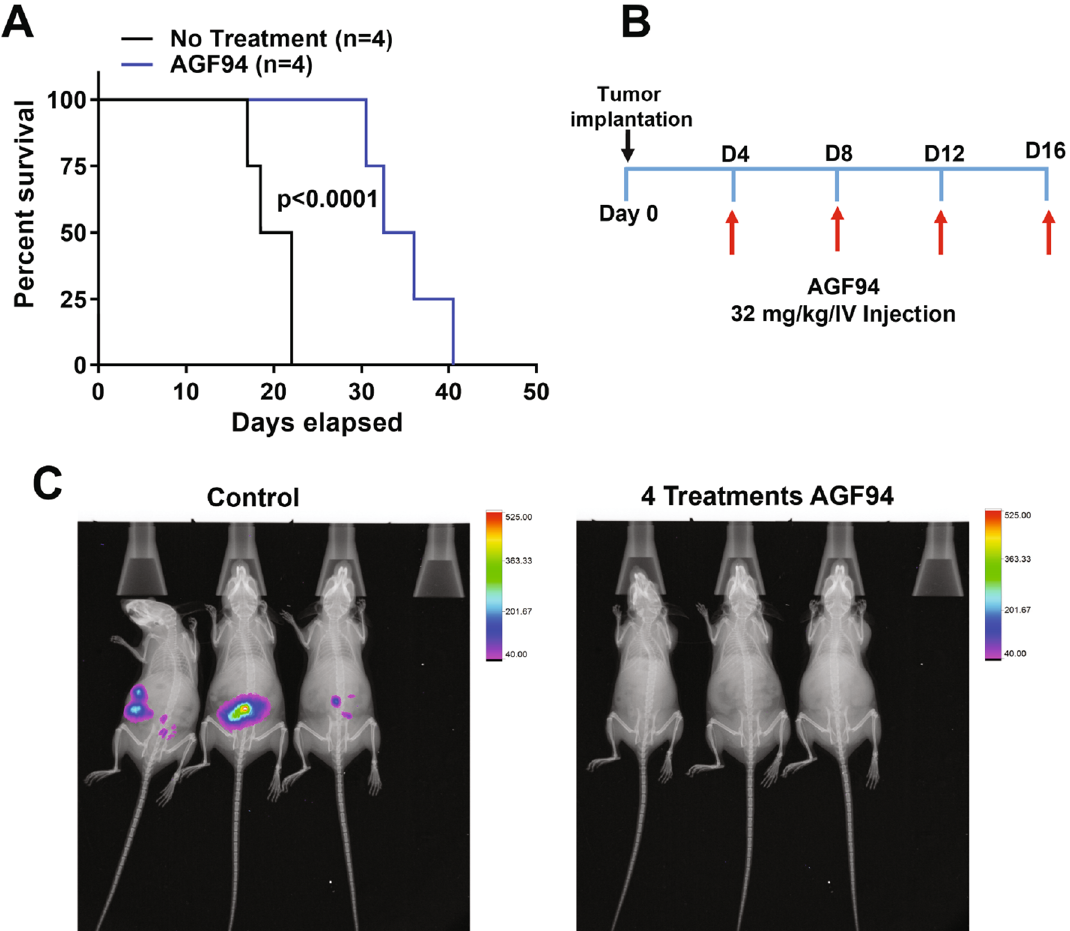
Figure 4. AGF94 efficacy trial in the IP BR-Luc model. Overall survival ( A ) and tumor burden ( C ) are shown for IP BR-Luc tumors in FVB mice following treatment with AGF94 (32 mg/kg × 4 doses). ( A ) A Kaplan–Meier survival analysis was performed on 4 mice treated with AGF94 (32 mg/kg × 4 doses). For control mice, a median of 22 days was measured compared to a median of 33 days for the AGF94 -treated mice. Statistical analysis was performed using the log-rank test. ( B ) The treatment scheme is shown. ( C ) Luminescent images are shown for a separate cohort (3 mice) over 3 min for control and AGF94 -treated mice treated with 4 doses at 32 mg/kg and overlayed on top of an X-ray